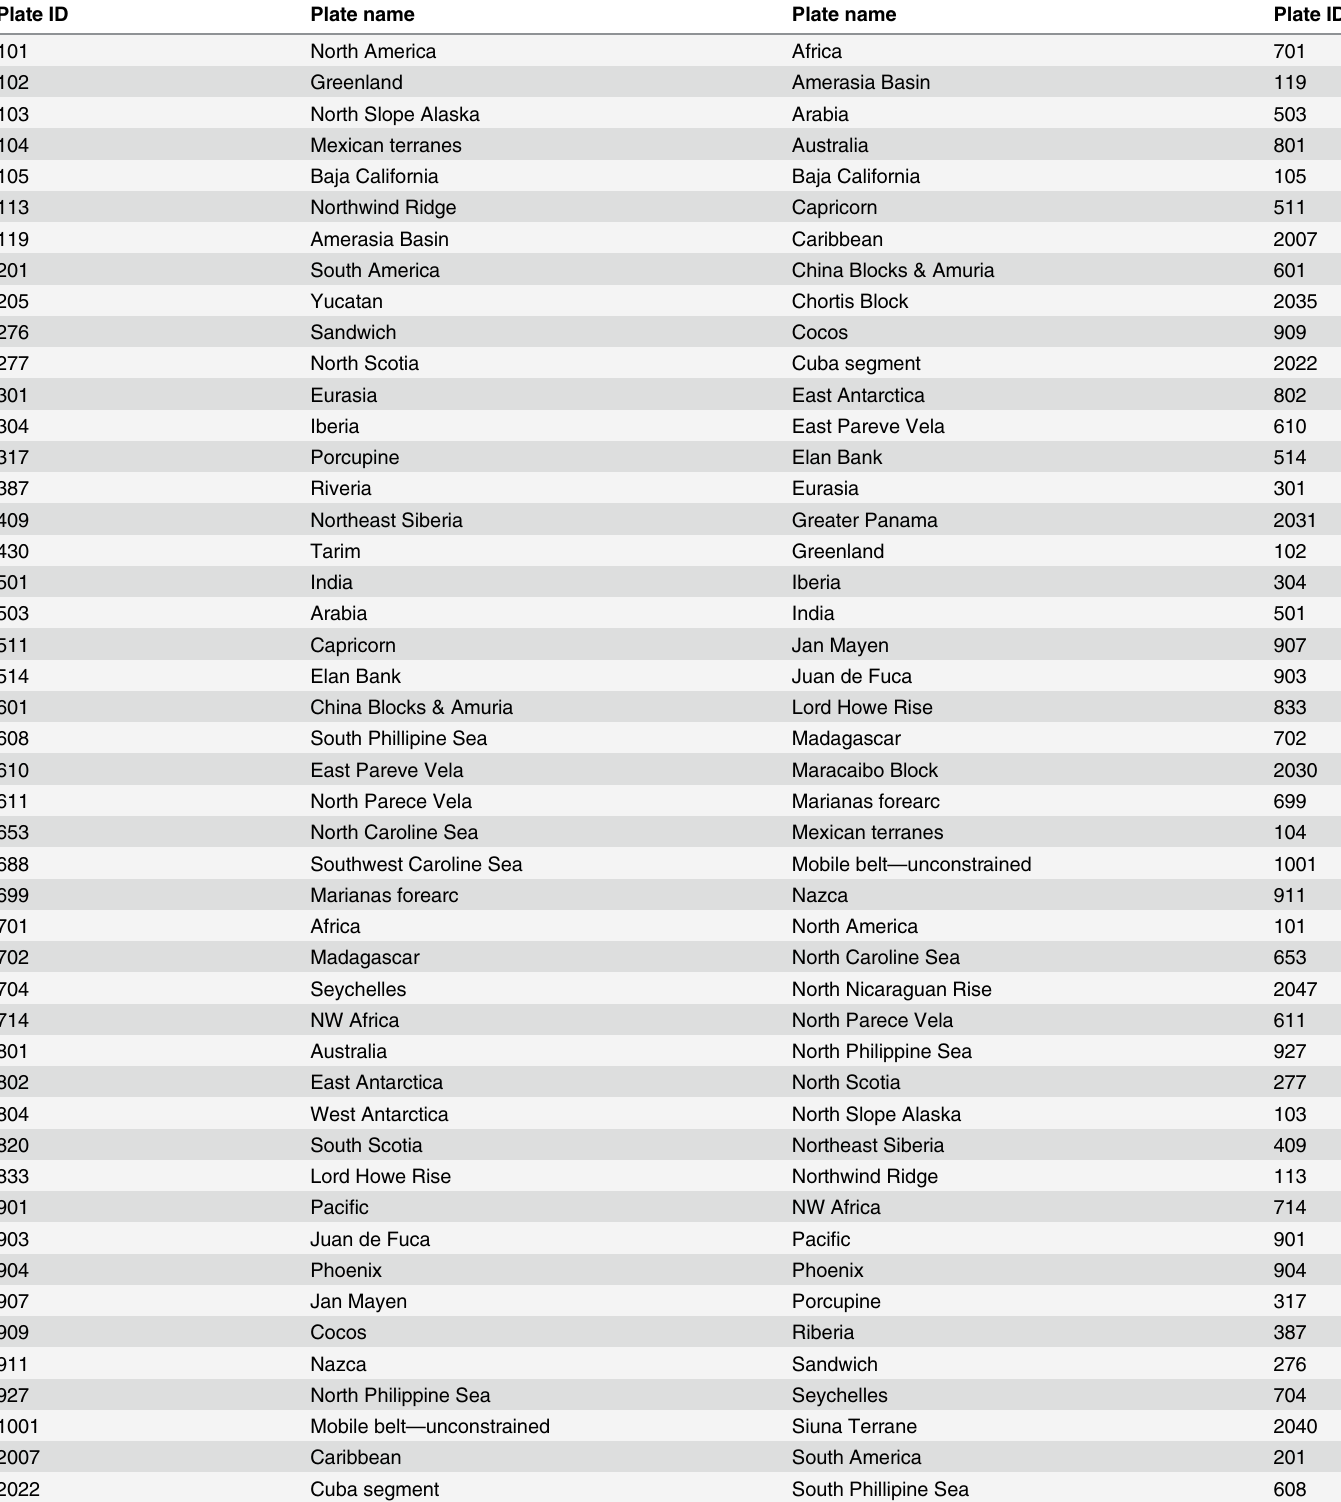
Table 1. List of codes and associated polygons representing plates or plate fragments used to build the global plate motion chain of Fig